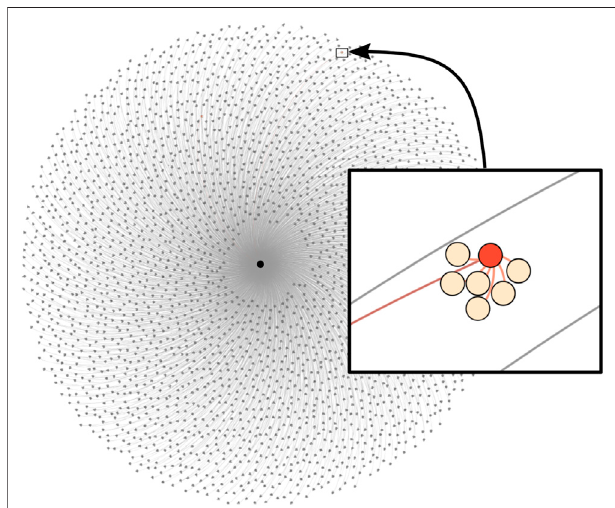
calculations (red circle) which is connected to outgoing nodes (colored in light orange).